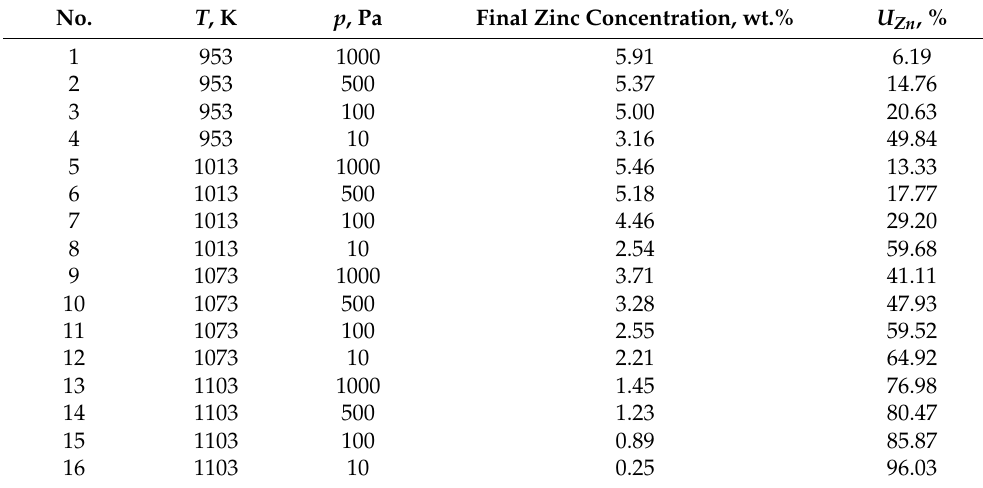
Table 2. Results of the experiments performed in the crucible induction furnace (VIM). No. T , K p , Pa Final Zinc Concentration, wt.%